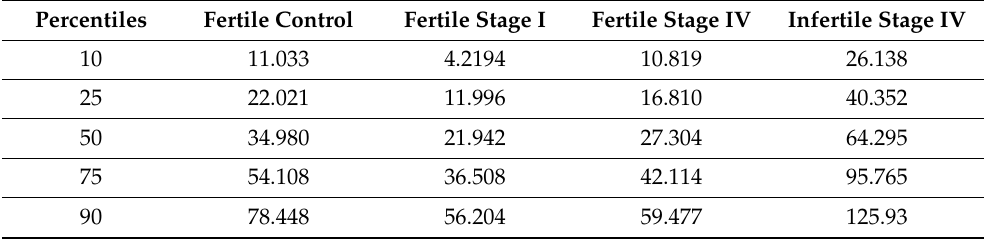
Table 3. Percentiles of BCL6 intensity and distribution in control, endometriosis (Stage I and IV), and infertility-associated endometriosis stage IV